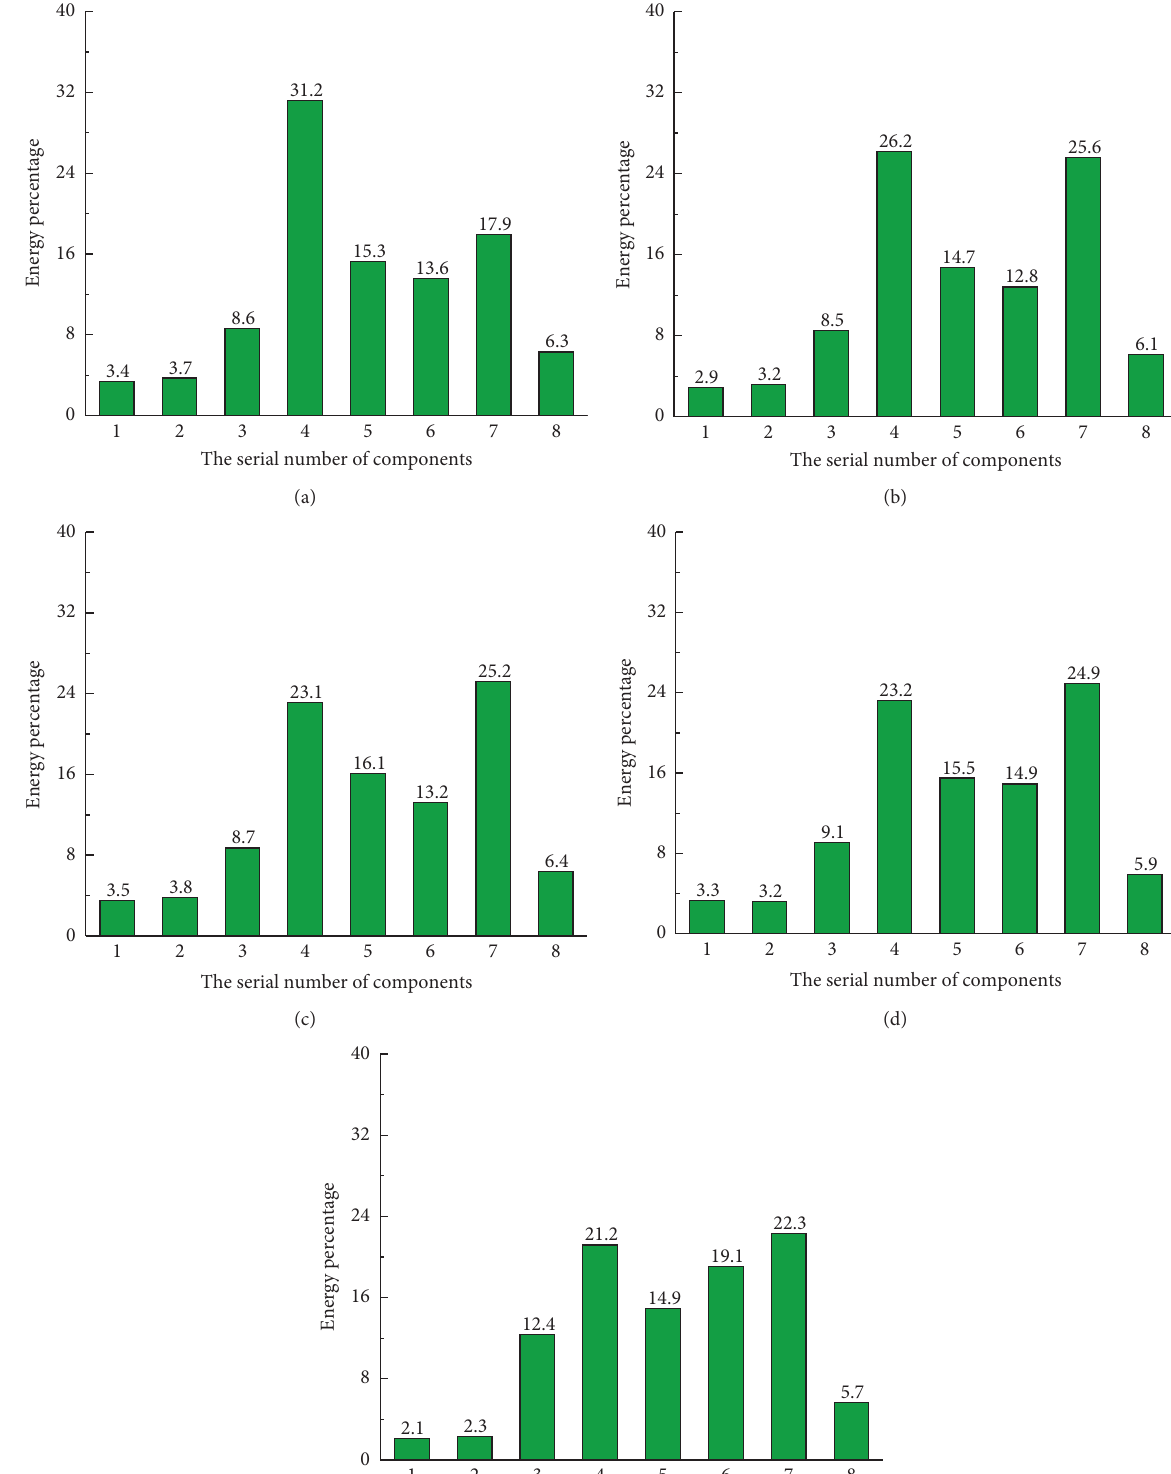
Figure 9: Frequency band energy histogram of acoustic emission signals of coal-like material samples under different borehole ar- rangements. (a) Scheme I 03: complete samples. (b) Scheme II 02: samples with boreholes. (c) Scheme III 02: samples with borehole with stepwise increased borehole depth. (d) Scheme IV 01: samples with borehole with stepwise increased borehole diameter. (e) Scheme V 03: samples with borehole with stepwise increased borehole depth and borehole